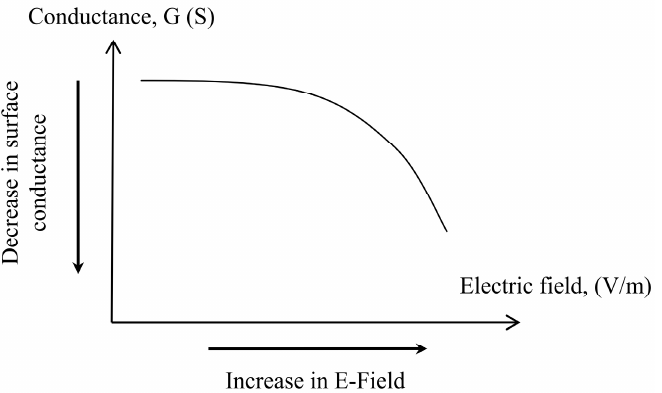
Figure 4. General representation of surface conductance as a function of the surface electric field.